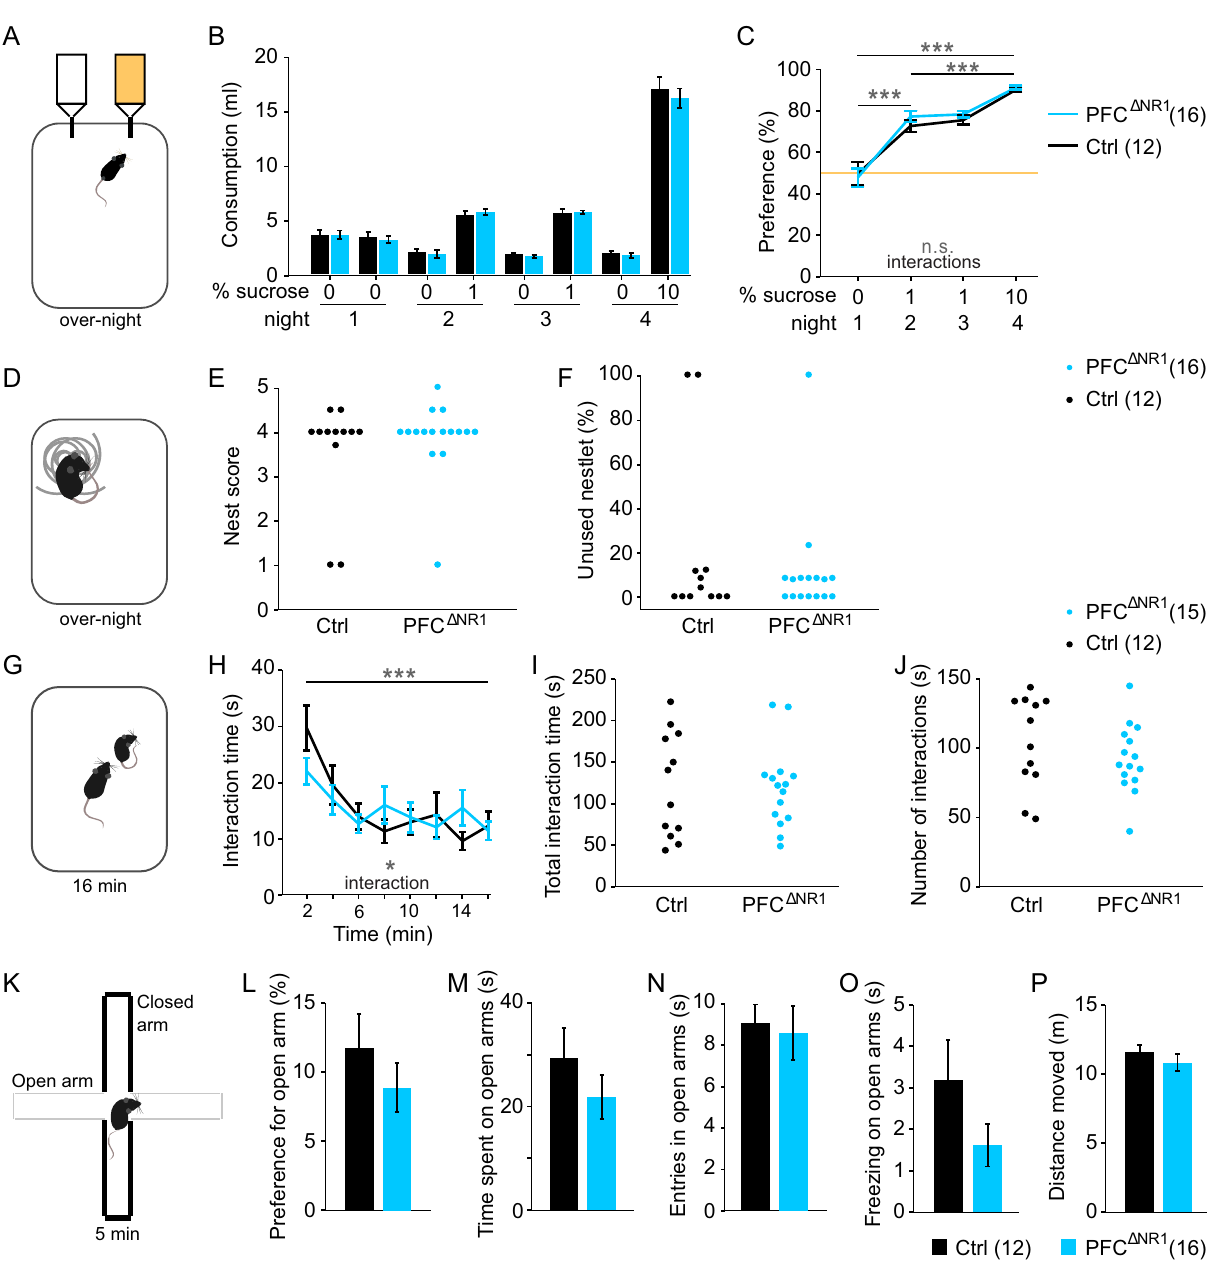
Figure 6. Assessment of social and emotional functioning . ( A ) Illustration of sucrose preference test conducted over-night while animals are single-housed. ( B ) Consumption of drinking water from each of the two bottles containing the stated concentration of sucrose across 4 nights. ( C ) Same data as in (B) but expressed as sucrose preference ratio (100*volume of water consumed from the designated sucrose-bottle/total water consumption) in %. Orange line shows chance level. Statistical indicators refer to RM ANOVA across the indicated nights and the two groups; there were no significant effects of groups or interactions. ( D ) Illustration of the nest building test. ( E, F ) Dot-graphs displaying the nest score and relative amount of unused nestlet (intact bits of nestlet heavier than 0.1 g) for each mouse. Analysis with MWU-test revealed no significant effect of group. ( G ) Assay of reciprocal social interaction in a novel open field. ( H ) Time spent in active social interactions in 2 min intervals over the 16 min test. Grey indicators, effect of time bin and group-time interaction in overall RM-ANOVA; no effect of group was found. ( I, J ) Dot-graphs displaying the total time (I) and number (J) of interactions made during the complete test; no effect of group was found ( t -test). ( K ) Illustration of the elevated plus-maze with two open arms (grey) and two closed arms (black). ( L ) Preference to spent time on the open arm relative to the time in closed arms. ( M ) Total time spent on open arms, during the 5 min test. ( N ) Total entries into any of the open arms. ( O ) Total time spent freezing on the open arm. ( P ) Total distance moved during the test. No effect of group was found ( t -test). The legends indicate the colour-code and size of each group for every experiment. See also Supplementary Table 4 for all related statistics. n.s., P > 0.1, * P < 0.05, *** P < 0.001. Error bars,